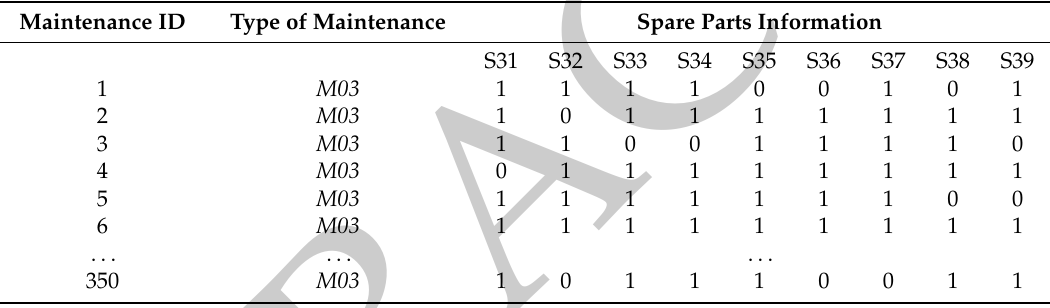
Table 9. The spare parts information for M03.